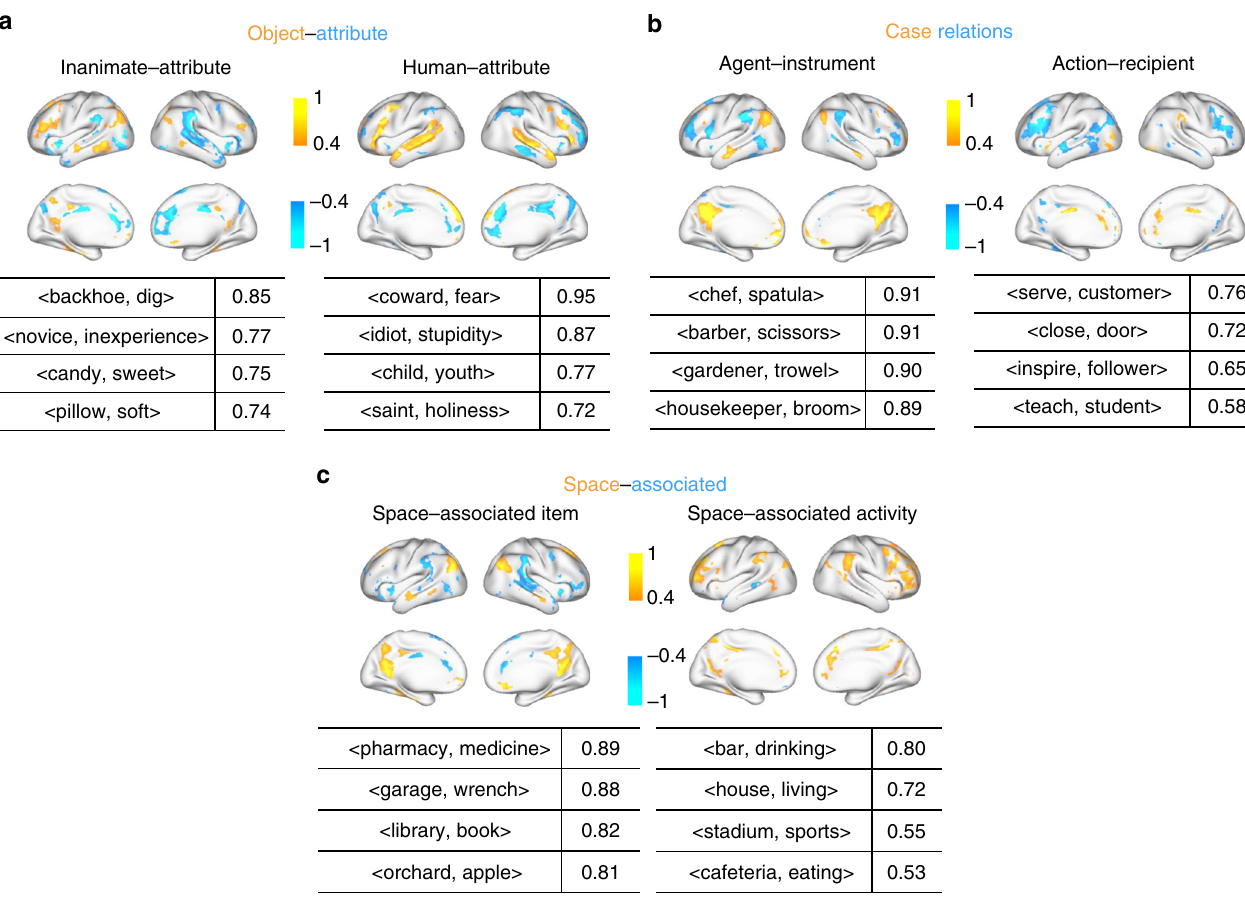
Fig. 8 Multiple cortical patterns represent subclasses of individual semantic relations. For three semantic relations: “ object-attribute ” ( a ), “ case relations ” ( b ), and “ space-associated ” ( c ), multivariate pattern analysis revealed two cortical patterns associated with each of these relations. The cortical patterns were min – max normalized to [ − 1, 1]. The table lists the top-4 word pairs, of which the cortical projection was most similar (in terms of cosine similarity) with the fi rst (left) or second (right) cortical pattern associated with each relation. See Supplementary Fig. 9 for results about other generalizable and transferrable across word pairs in the same semantic relation (Supplementary Figs. 6 and 7). This leads us to hypothesize that the semantic space includes continuous vector fi elds, each of which represents a semantic relation and is likely applicable to various concepts or even domains of concepts.